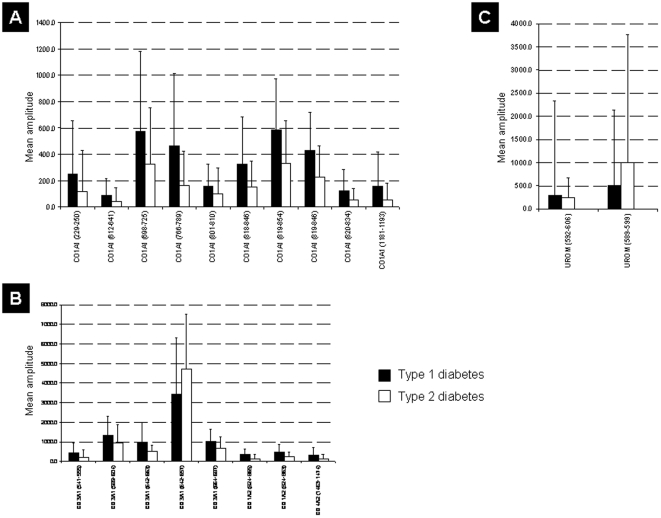
Regulation of identified statistically significant peptide markers for diabetes type in the discovery set.Given are SwissProt accession names. (A) Regulation of collagen alpha 1 (I) fragments. (B) Regulation of other types of collagen fragments. (C) Regulation of uromodulin fragments.